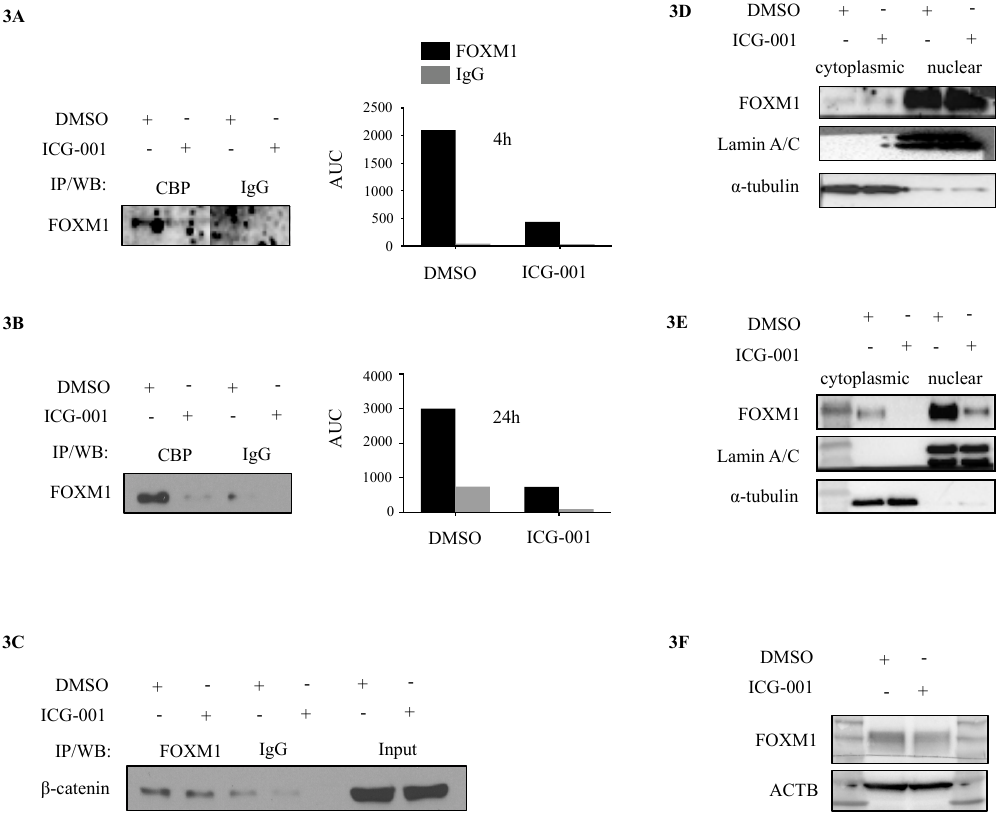
Figure 3. Effect of ICG-001 on CBP/FOXM1/ β -catenin binding and FOXM1 protein levels. ( A ) CoIP of CBP with FOXM1 in MDA-MB-231 treated with for 4h and ( B ) 24 h with 20 µ M ICG-001 or DMSO vehicle control (AUC DMSO 6006 ± 1500 vs. ICG-001 1480 ± 185, n = 1) (IP–Immunoprecipitation, WB–Western blot). ( C ) FOXM1 pull down and staining for associated β -catenin with or without addition of ICG-001. ( D ) Western blot showing protein levels of FOXM1 after 4 h and ( E ) 24 h treatment of MDA-MB-231 with ICG-001 or DMSO (cytosolic fraction in columns 2 and 3, nuclear fraction in columns 4 and 5). The first column is a protein marker to determine the molecular weight of each protein band. ( F ) FOXM1 levels in MDA-MB-468 TNBC cells after 24 h treatment with ICG-001 or DMSO control. The first and last column is a protein marker to determine the molecular weight of each protein band.